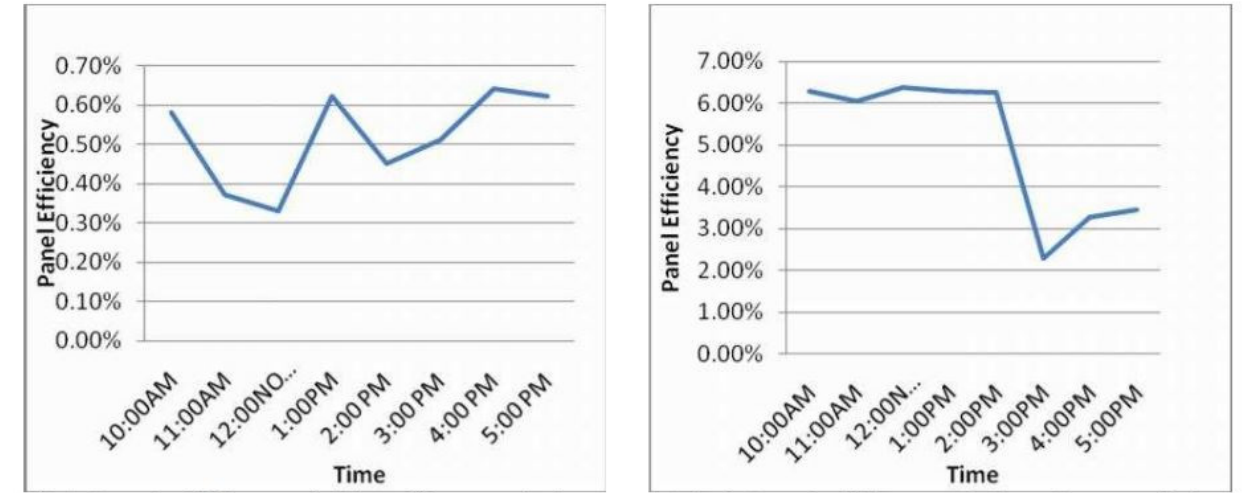
Figure 21. PV panel efficiency with dust ( Left ) and without dust ( Right ) with respect to time characteristics [114].